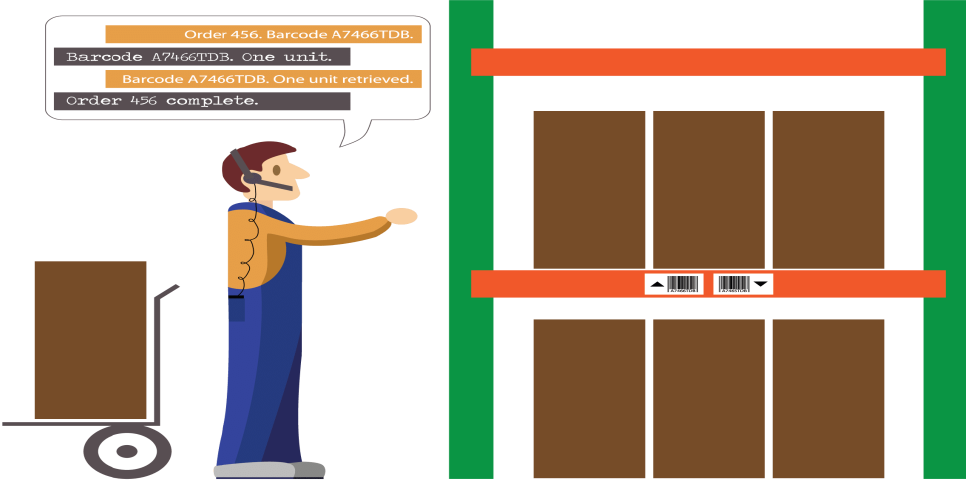
Figure 4. Order picking by voice recognition